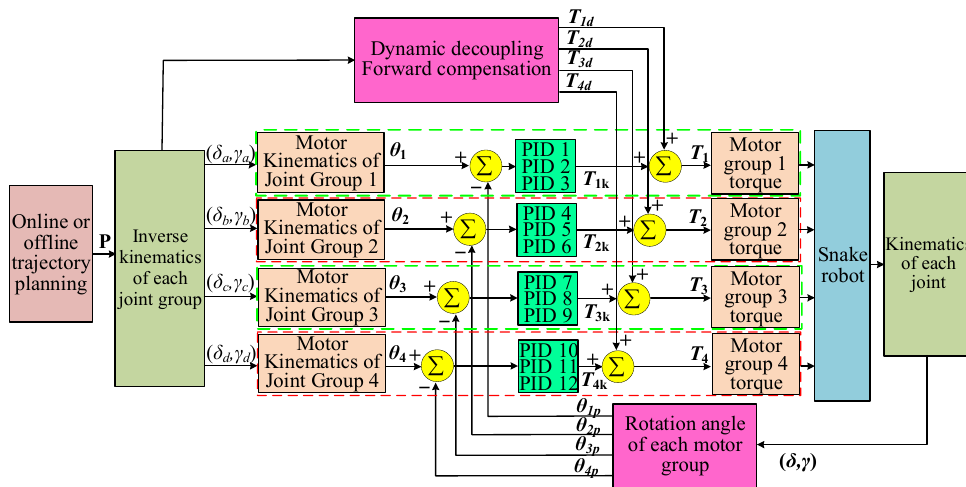
Figure 8. Model-based equivalent dynamic control principle.